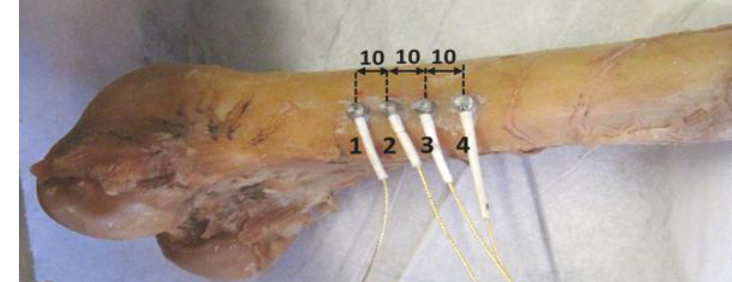
Figure 1. Acoustic emission sensors placed on the femur diaphysis (dimensions in